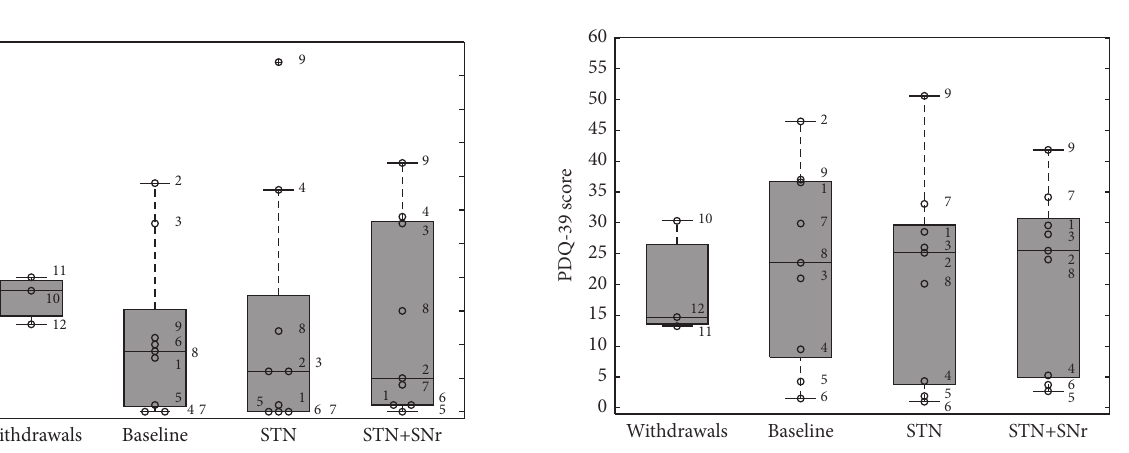
Figure 9: Boxplots of PDQ-39 scores expressed as Parkinson’s disease summary index (PDSI) scores: the box plot depicted on the leftrepresentsthebaselinevaluesofthethreepatientswhowithdrew. The other three box plots represent the values of the 9 PD patients who have completed the study at the three experimental time points: (1) baseline, (2) STN alone, and (3) combined STN+SNr-DBS. The numbered circles represent the single patients as listed in Table